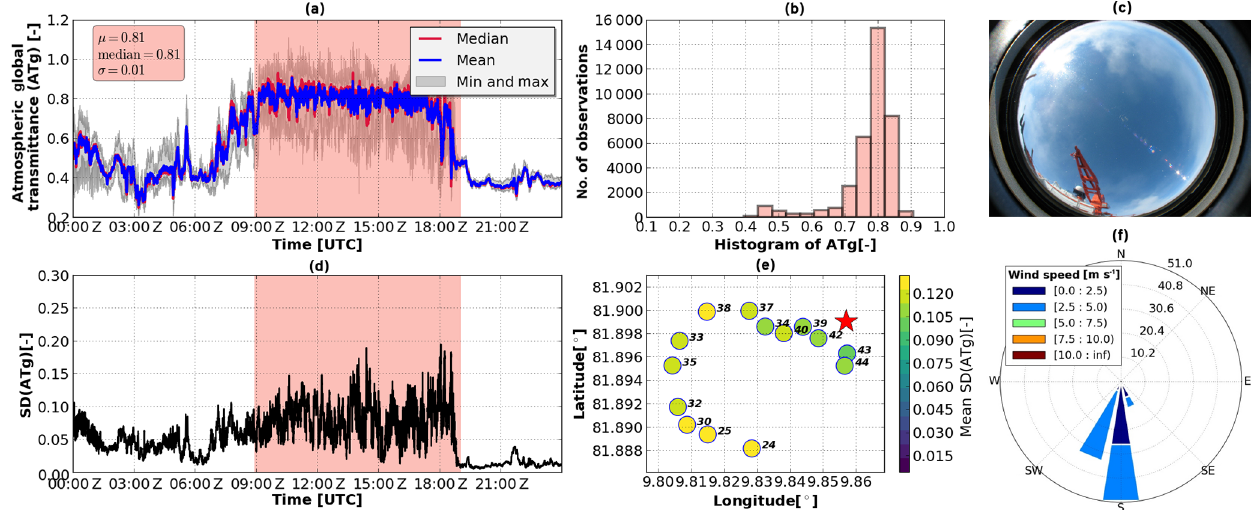
Figure 12. Overview of broken cloud case: the same as Fig. 6 but for 8 June 2017, 08:55–19:00Z. All-sky camera photograph taken at 12:41:14Z.